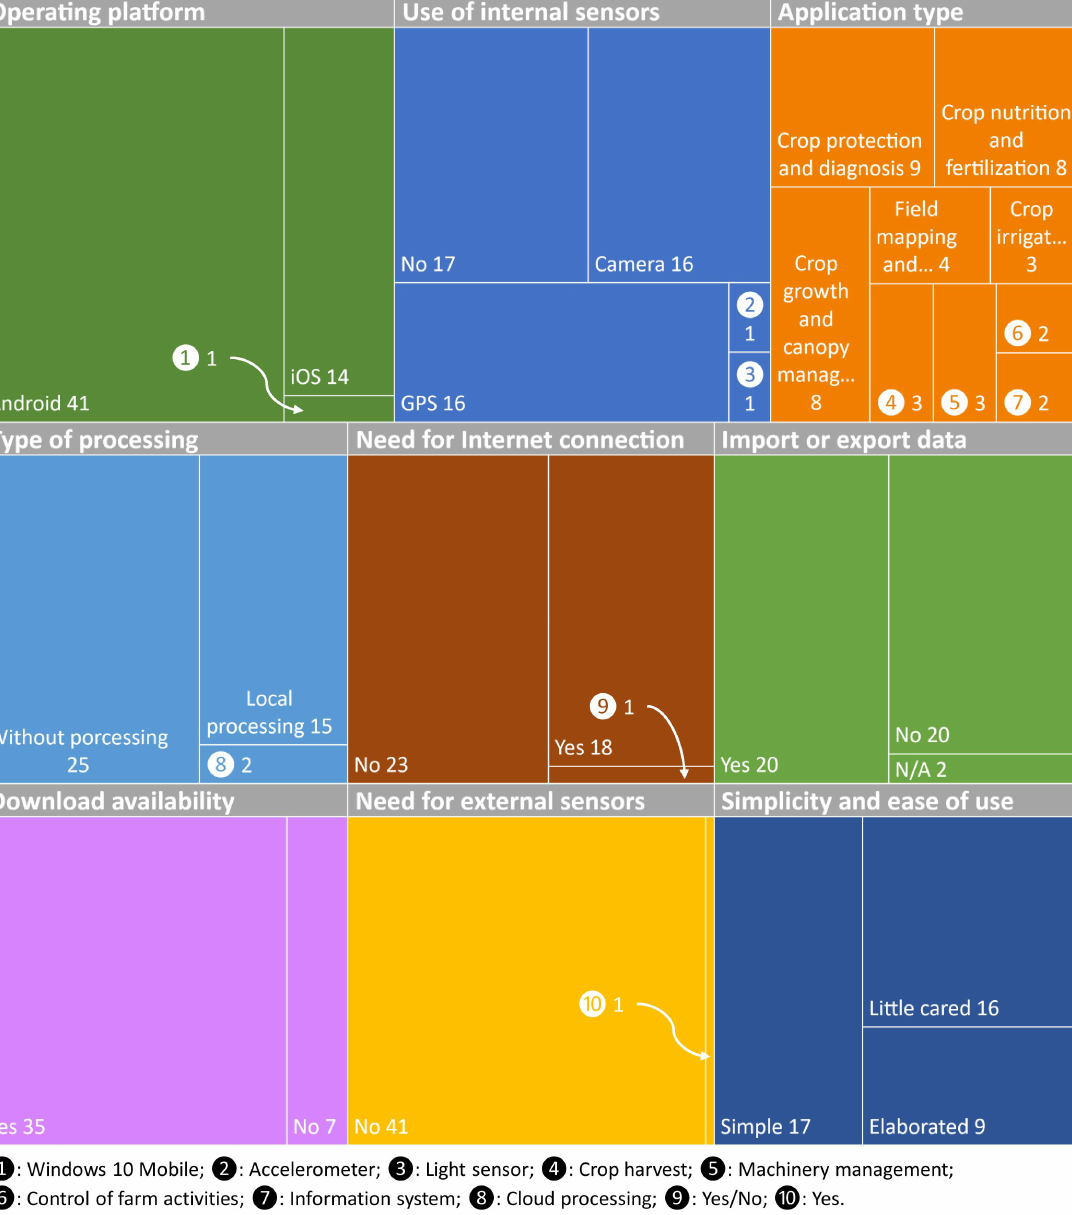
Figure 40. A treemap chart that summarizes the results obtained in this